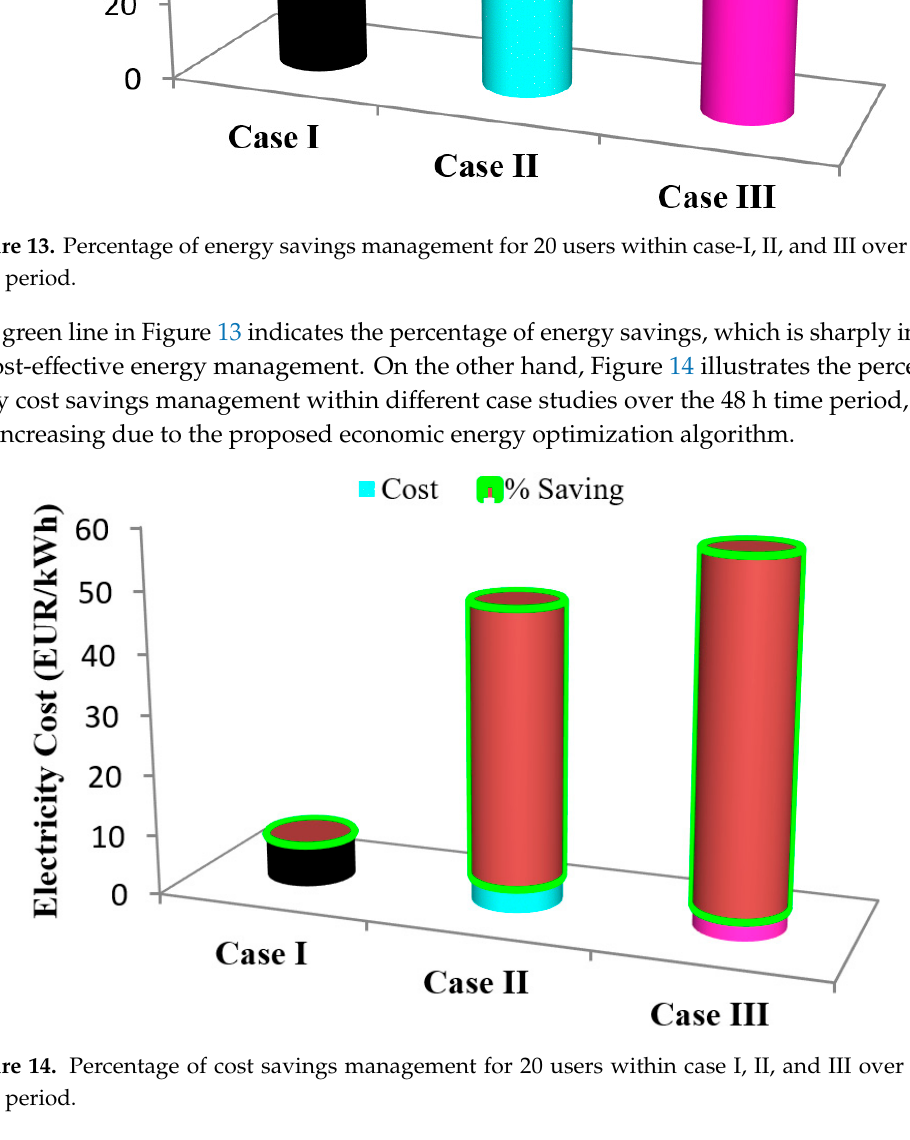
Figure 14. Percentage of cost savings management for 20 users within case I, II, and III over 48 h time period.